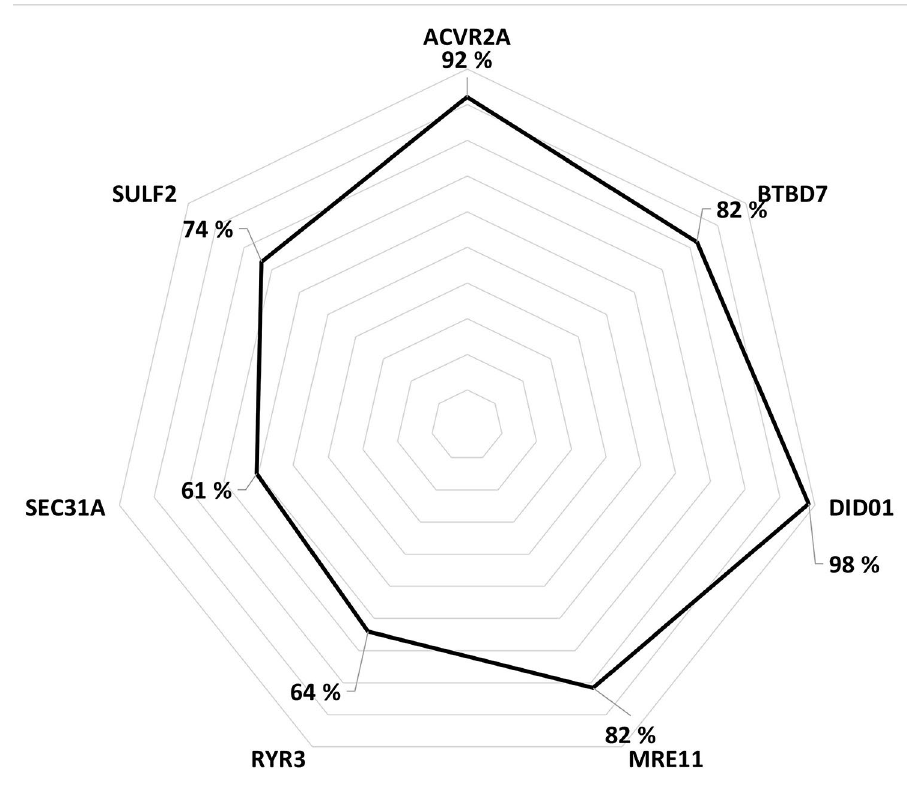
Fig. 2 Mutated biomarker spectrum in colorectal cancer biopsies detected MSI (n = 114) by Idylla MSI